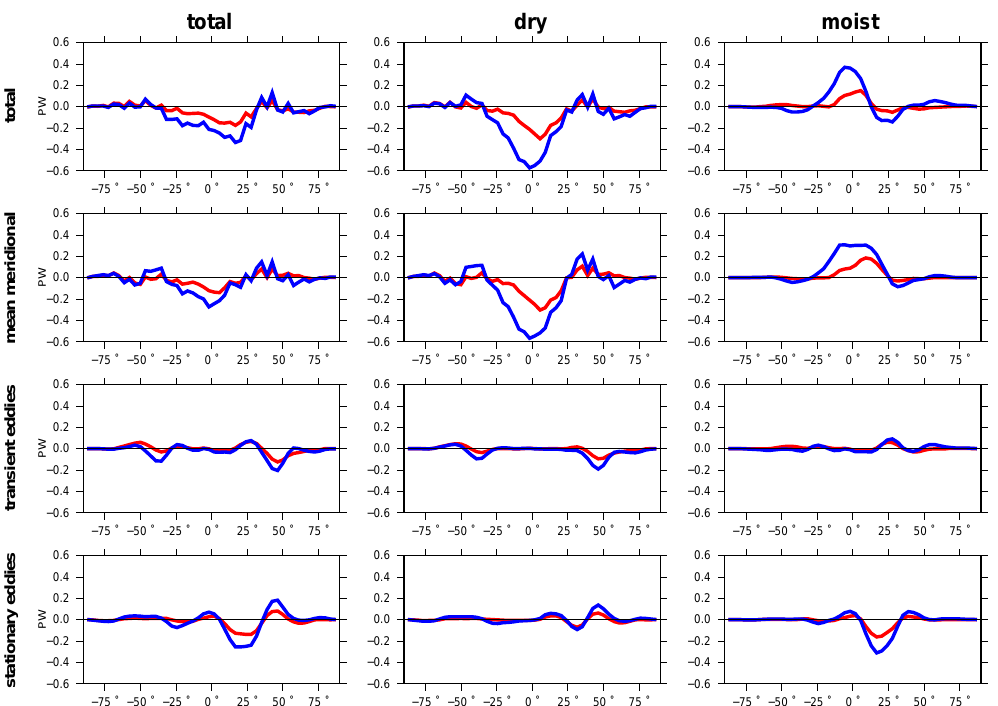
Fig. 3. Differences zonally integrated atmospheric heat transports (in PW - 10 15 W) averaged over 100 years (red line: Holocene - preindustrial; blue line - Eemian - pre-industrial) total (left column), dry or sensible heat (middle column) and moist or latent heat (right column) contributions. In the horizontal the rows show total, mean meridional, transient eddy and stationary eddy contributions from top to bottom.